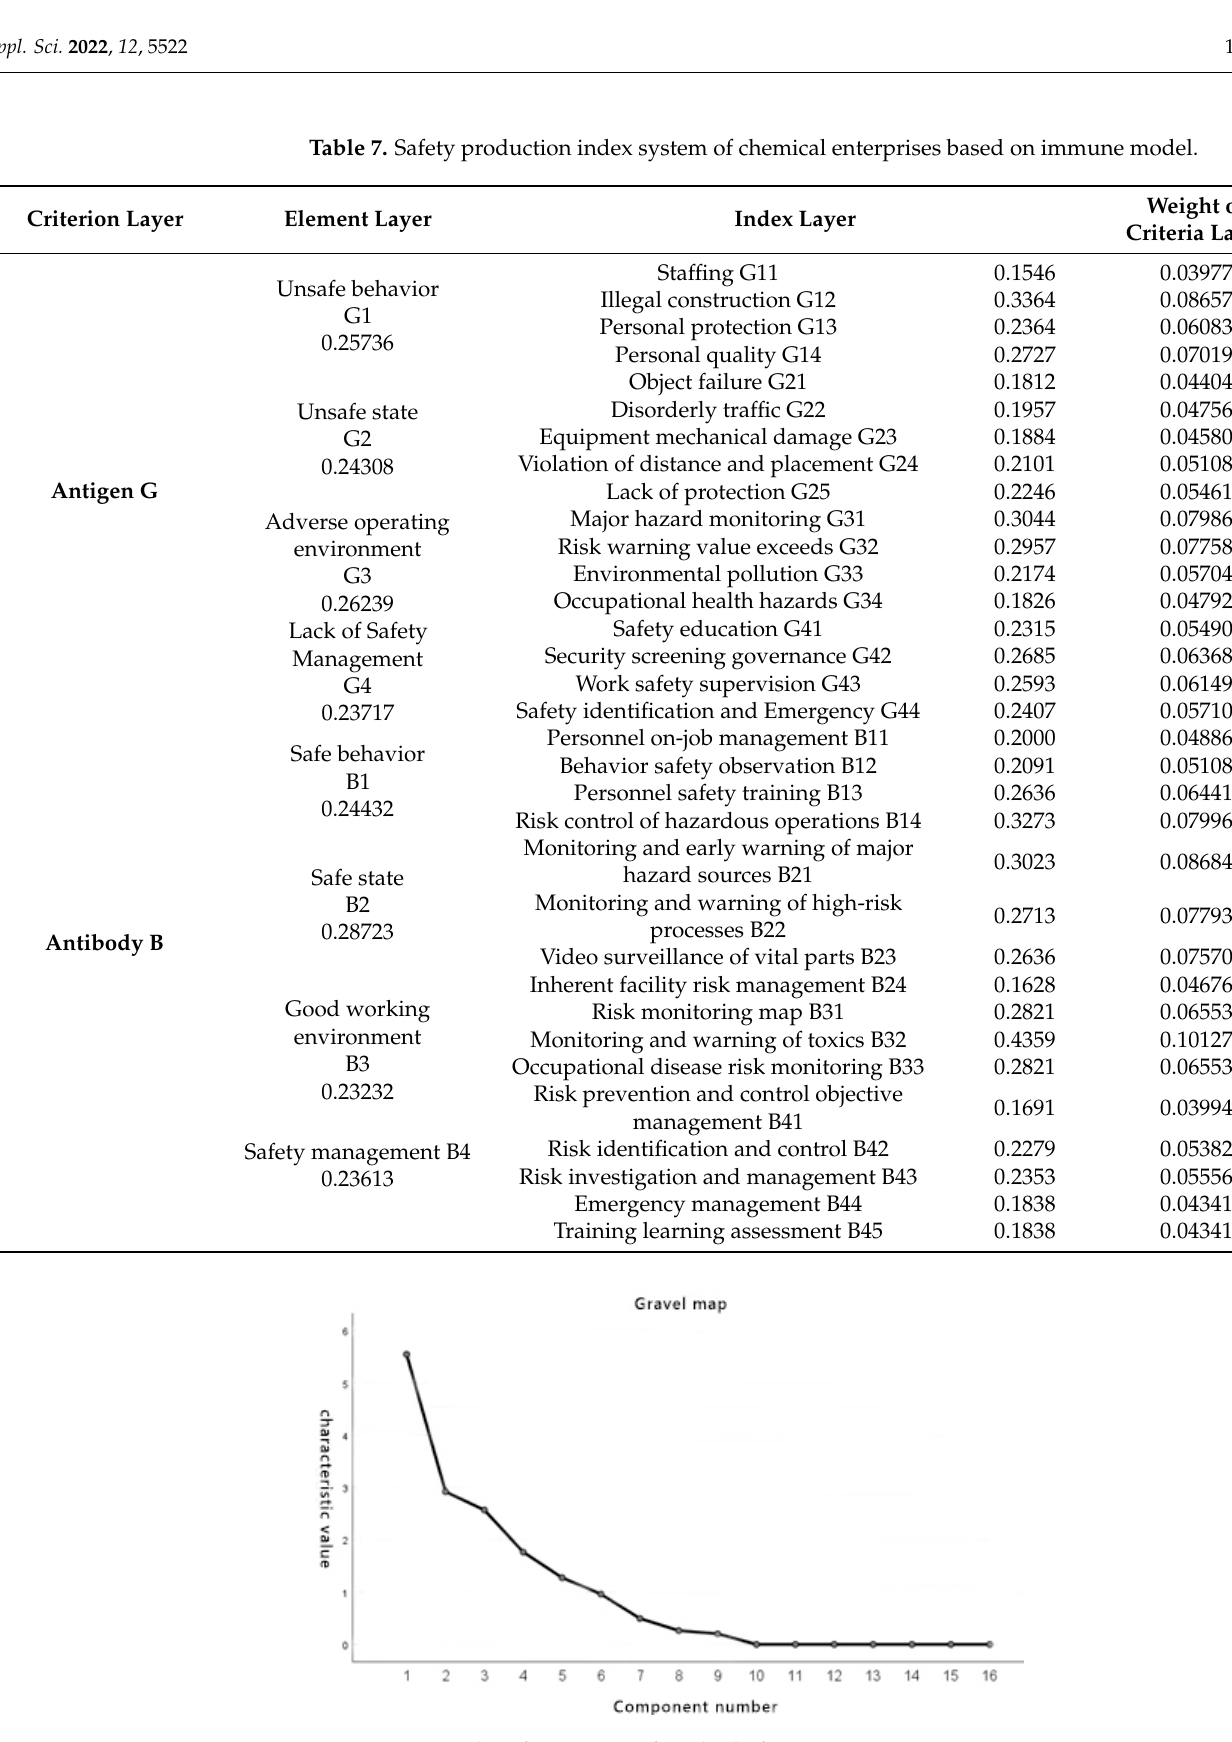
Figure 4. Scree plot of extraction of antibody factor